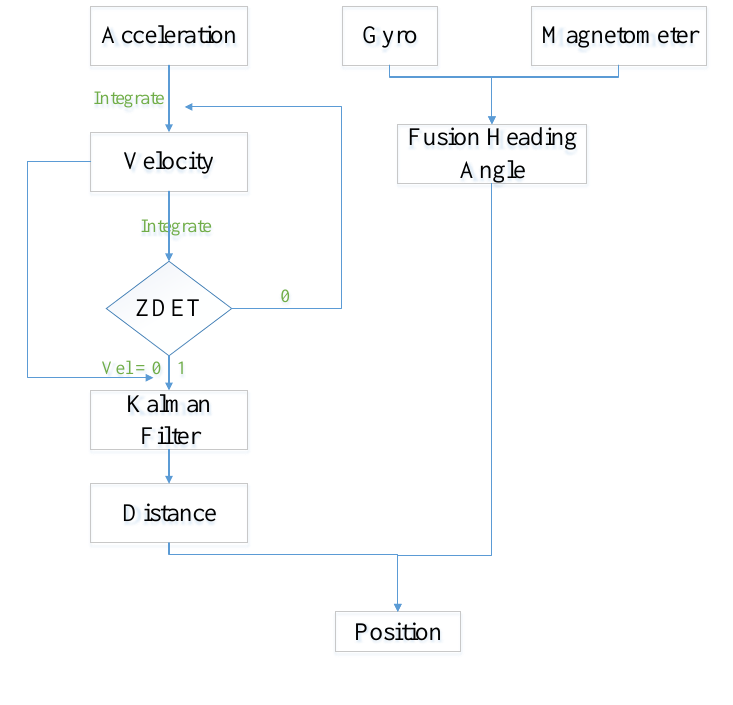
Figure 3. Flow chart of the improved